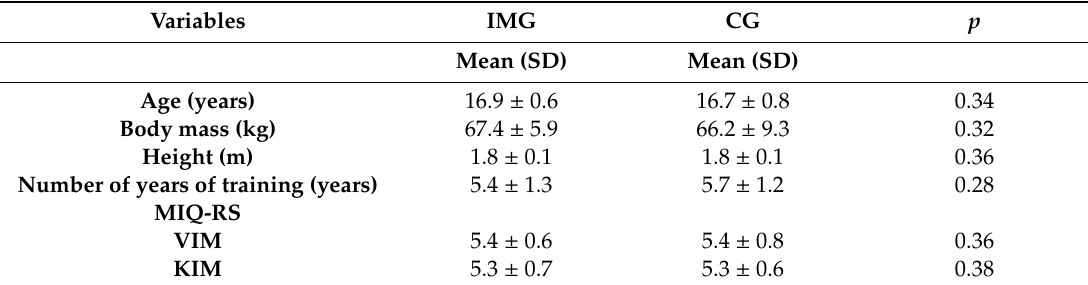
Table 1. Mean and standard deviation of descriptive research variables.